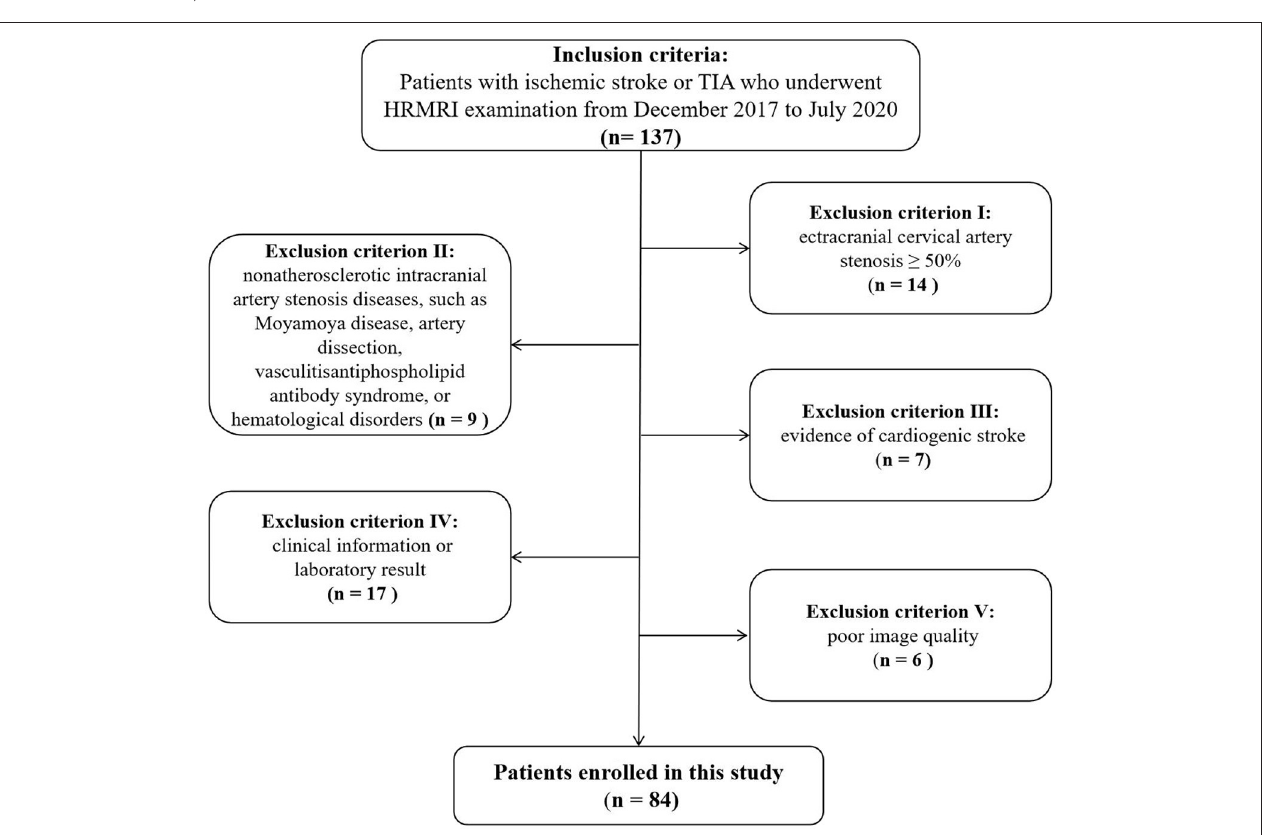
FIGURE 1 | Flow chart showing process of study population